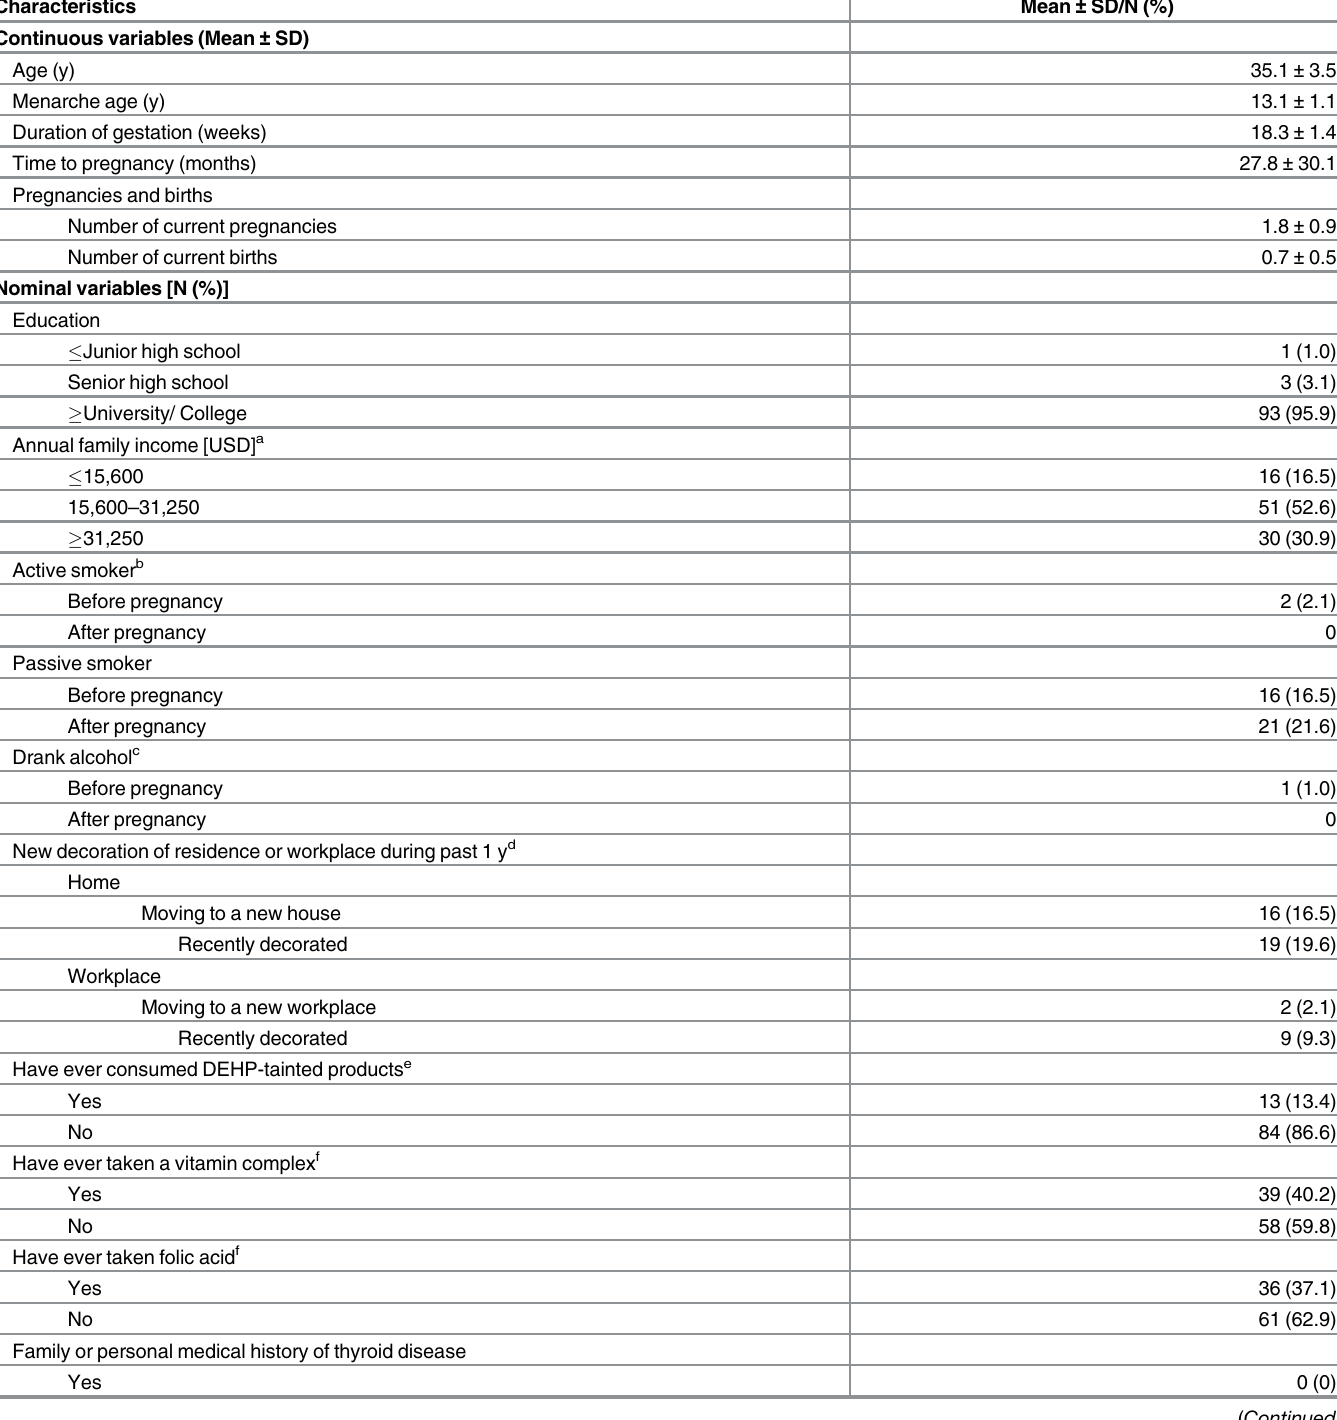
Table 1. Demographic Characteristics of Participating Pregnant Taiwanese Women (N =